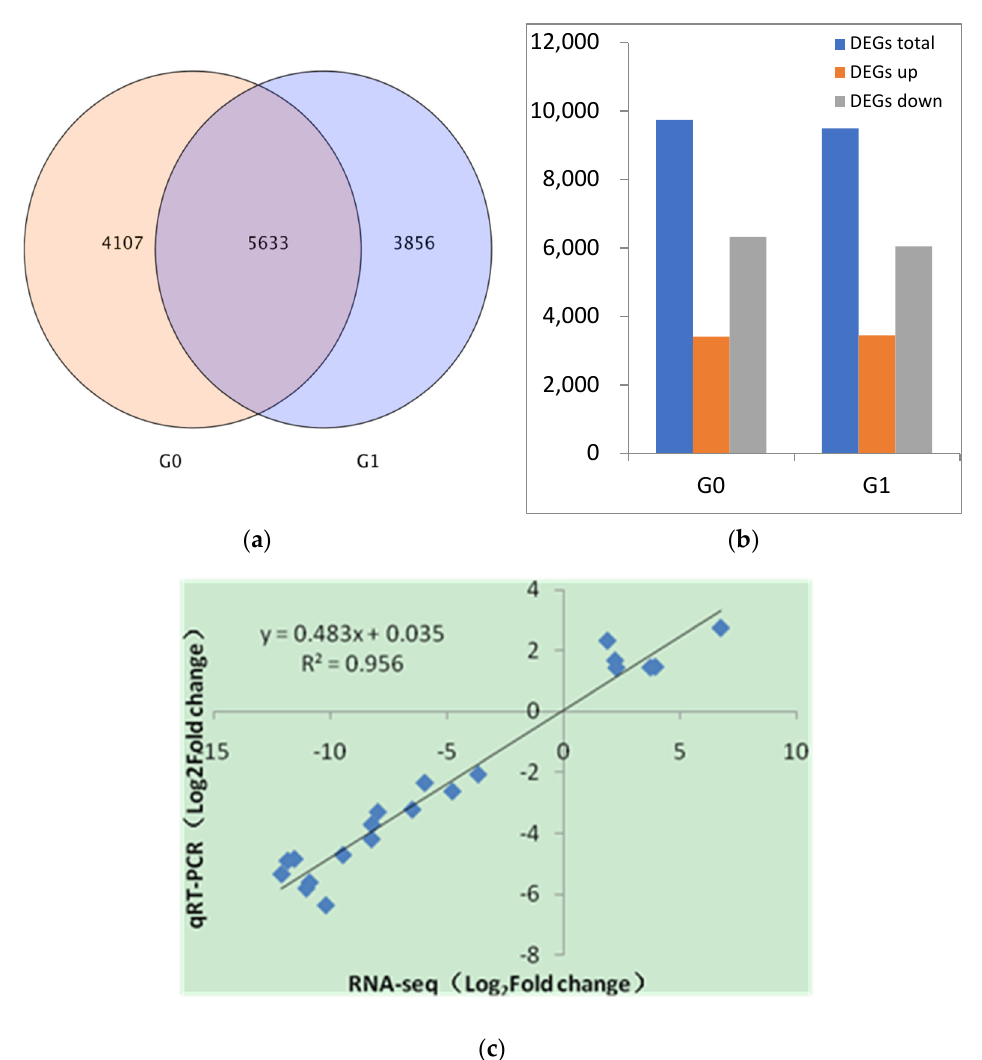
Figure 1. The number of DEGs between A. correntina and GH85 and qRT-PCR validation of selected DEGs. ( a ) Venn diagram of DEGs. G0: A. correntina -30d vs. GH85 − 30d. G1: A. correntina − 60d vs. GH85 − 60d. ( b ) The number of DEGs between A. correntina and GH85. ( c ) Linear regression analysis of RT-PCR and RNA-Seq data.